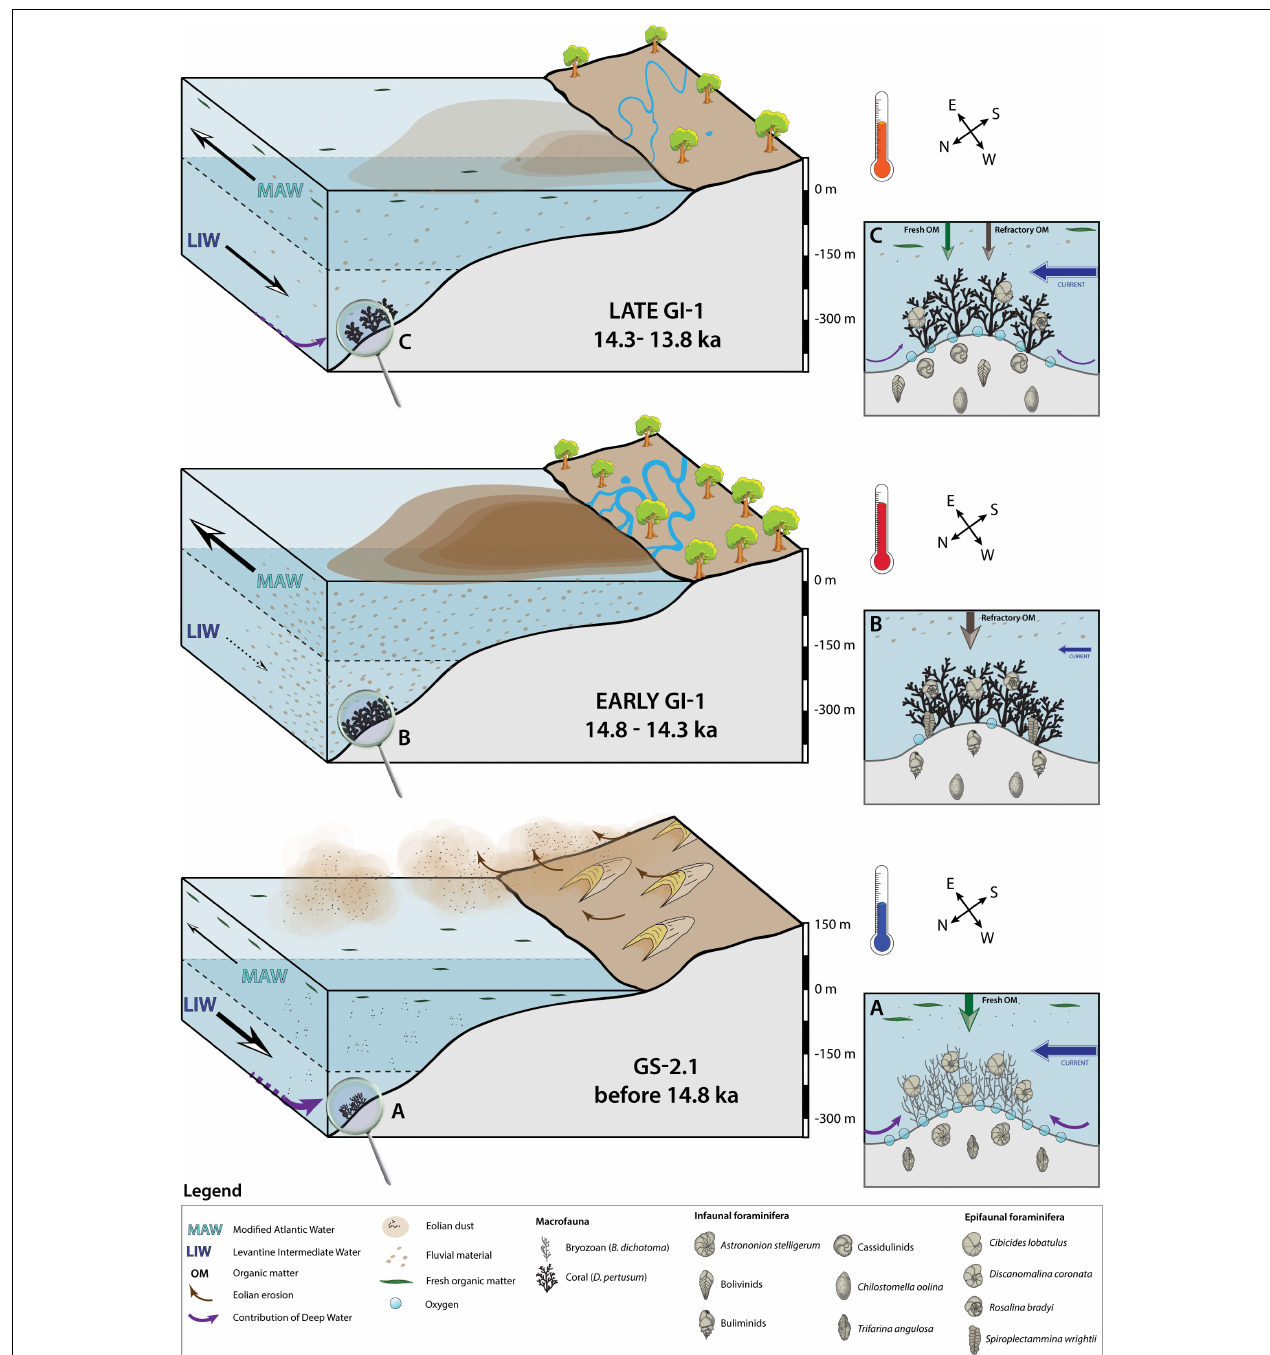
FIGURE 7 | Three-step diagram illustrating the environmental changes affecting Brittlestar Ridge I during Greenland Stadial 2.1 (GS-2.1) and Greenland Interstadial 1 (GI-1). Parts (A–C) are close-ups of the seafloor at Brittlestar Ridge I for each period. The illustrated foraminifera are selected based on the dissimilarity values provided by the Similarity Percentage analysis (Table 4) . The selected foraminifera do not encompass the complete assemblage of each time period and are a simplified interpretation. The illustrated macrofauna and microfauna are not to